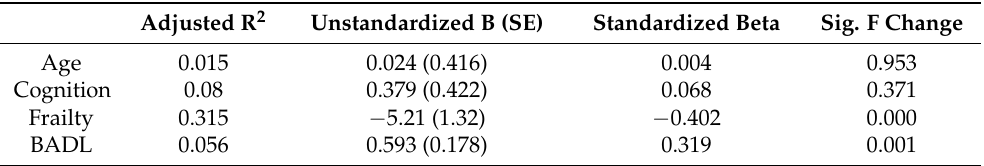
Table 4. A linear multivariate regression analysis model to examine the contribution of frailty to explaining